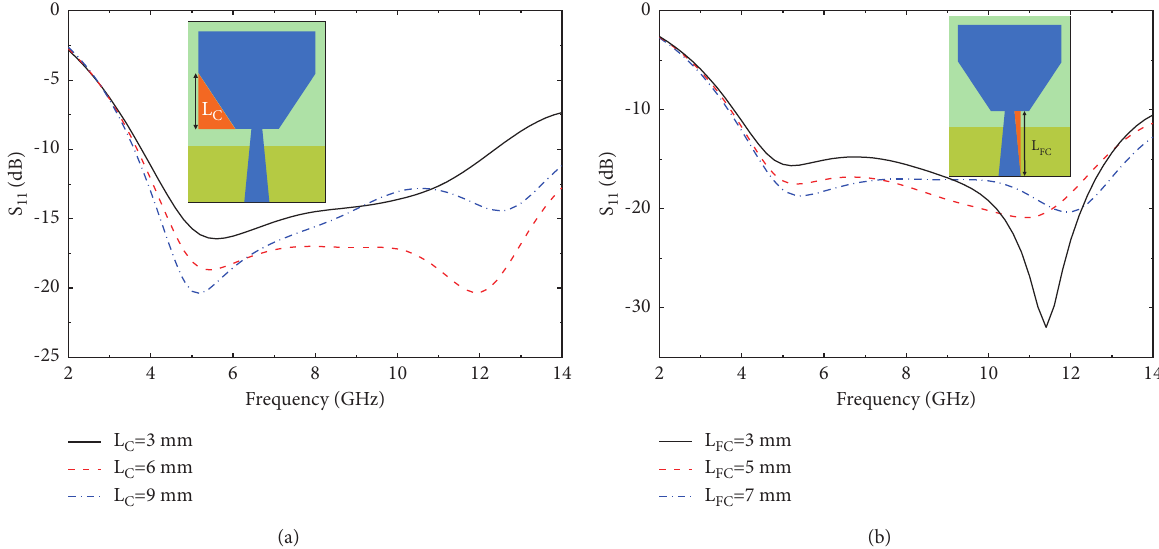
Figure 3: S 11 simulation results of different long-side values of truncated triangular slots. (a)